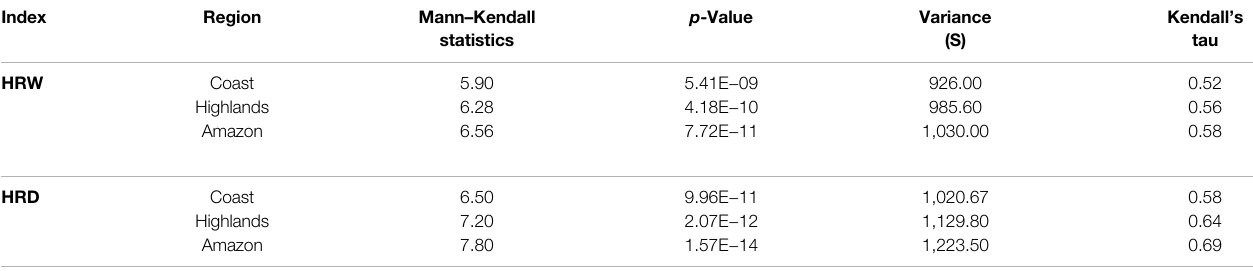
TABLE 4 | Mann – Kendall model result of the mean of the all-station index in each region derived from the GISS model. Index